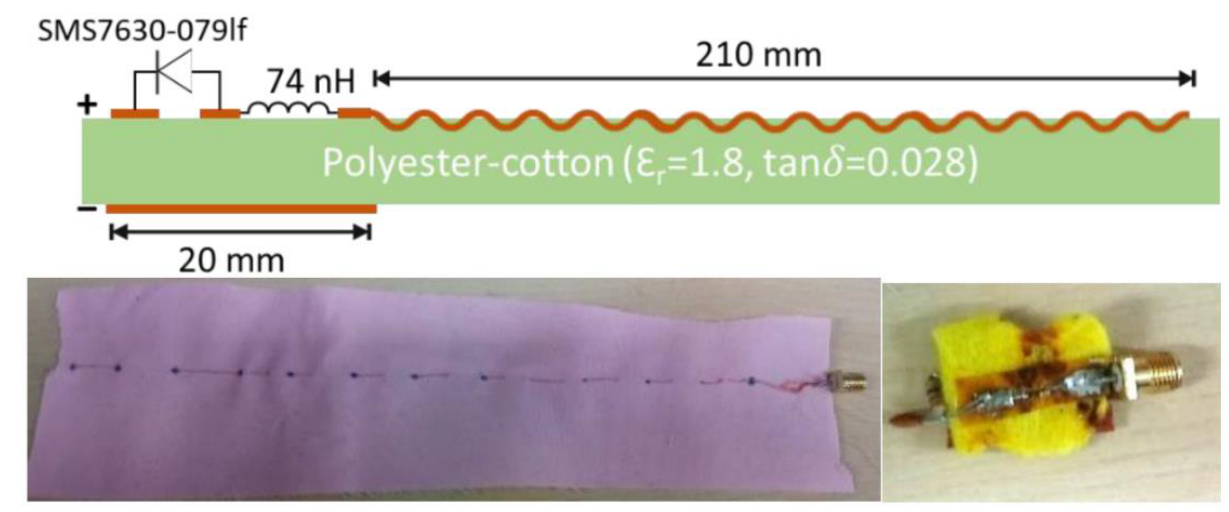
Figure 14. Textile-based rectenna; source: [75] (CC BY).